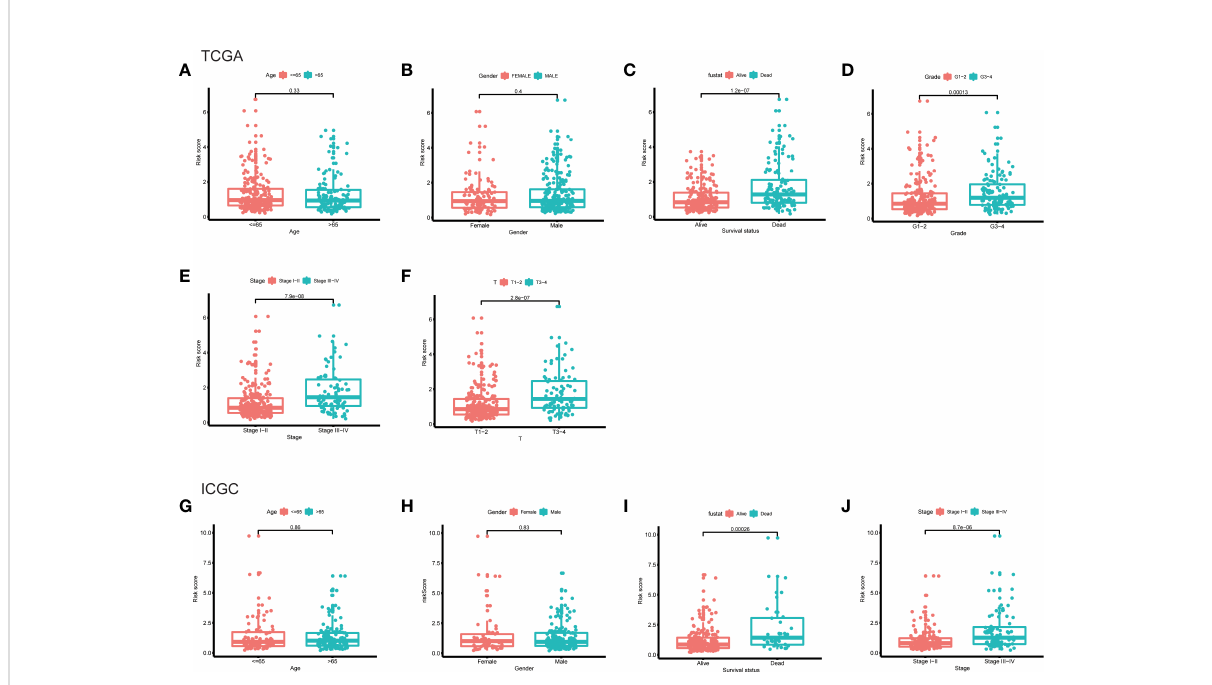
FIGURE 5 The differences of risk score between subgroups strati fi ed by different clinical characteristic in the TCGA and ICGC cohorts. (A) Age, (B) gender, (C) survival status, (D) grade, (E) stage, (F) T classi fi cation in the TCGA cohort. (G) Age, (H) gender, (I) survival status, (J) stage in the ICGC